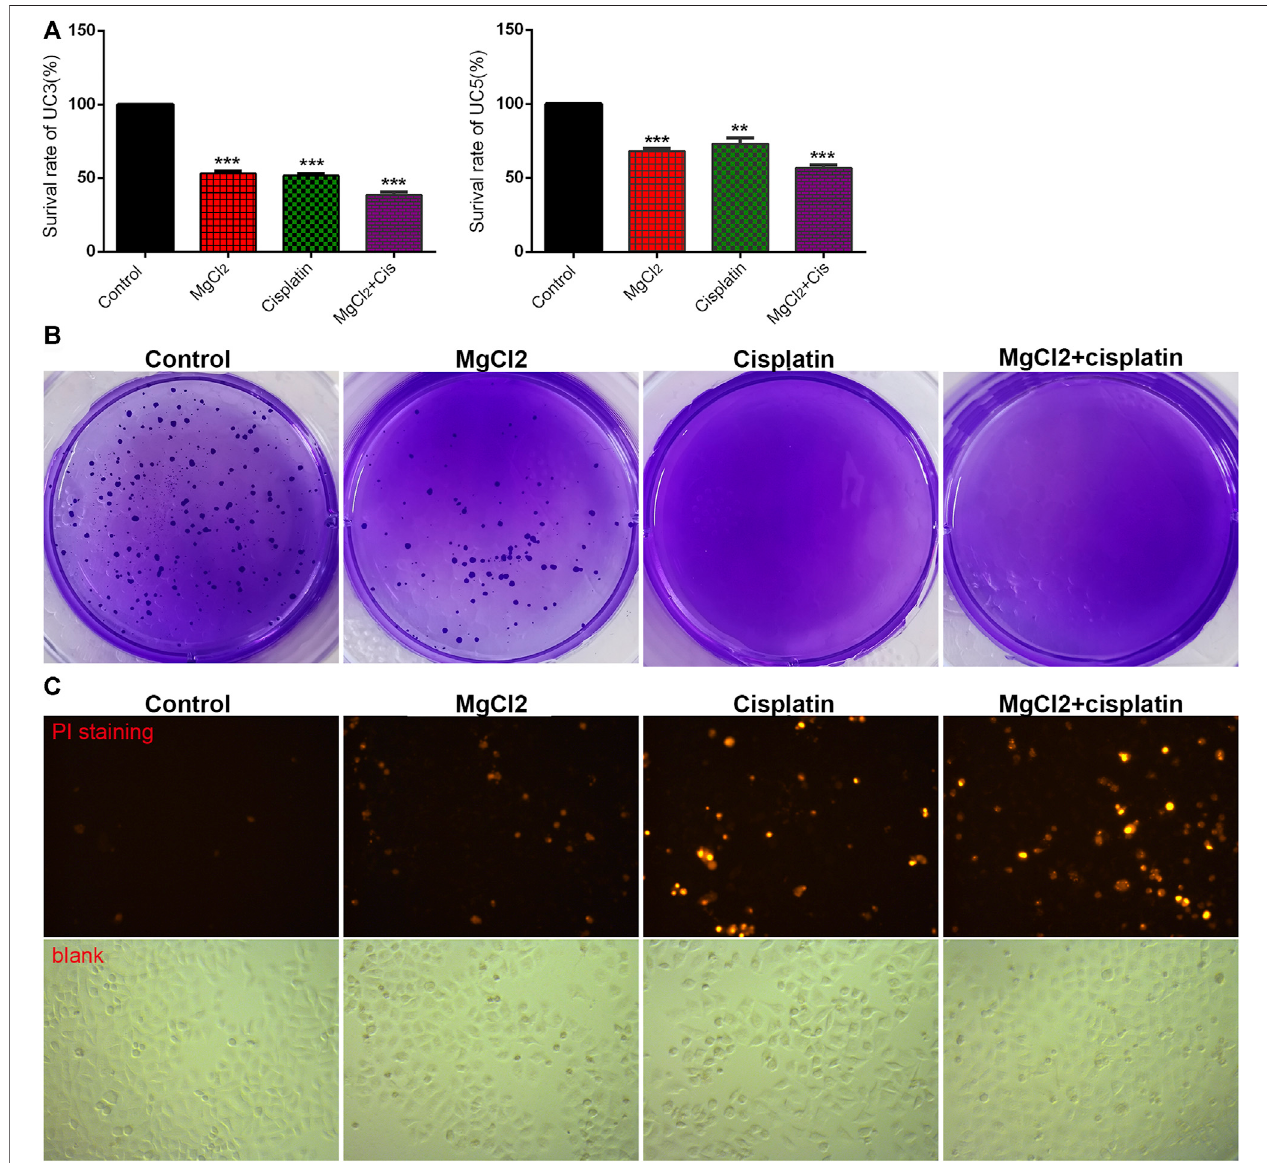
FIGURE 1 | Combinatorial treatment with MgCl 2 and cisplatin (Cis) suppresses the survival of bladder cancer cells. (A) The cell survival of MgCl 2 and/or cisplatin treated UC3 and UC5 bladder cancer cells for 24 h was examined by the CCK-8 assay. (B) The colony formation of UC3 cells treated with MgCl 2 and/or cisplatin. The results of quanti fi cation were presented in Supplementary Figure S1B . (C) PI staining of UC3 cells treated with MgCl 2 and/or cisplatin for 24 h. The immuno fl uorescence intensity of PI staining was showed in Supplementary Figure S1C .